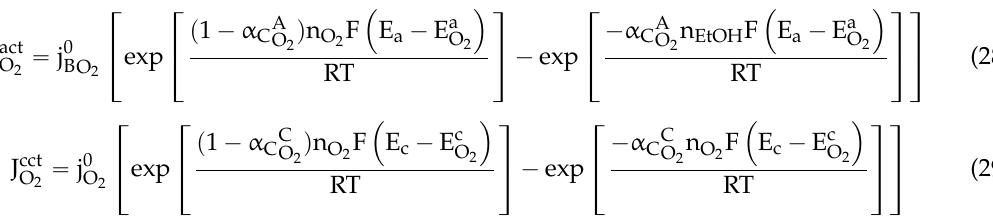
Table 4. Characteristics of the separators investigated in part 1 of this work [24]. Separator